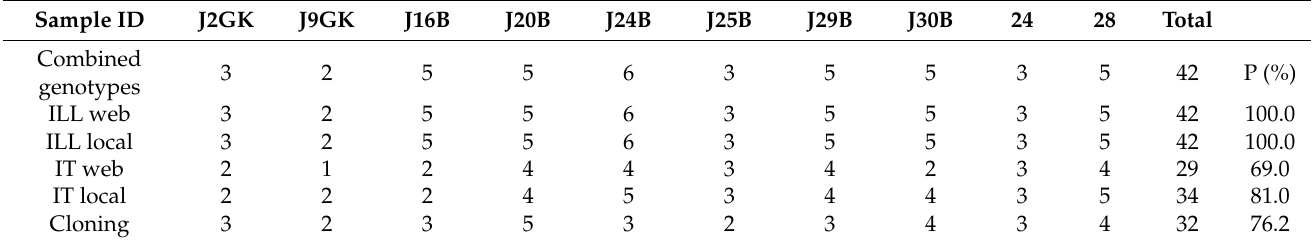
Table 3. MHC-DRB combined genotypes (number of combined alleles), number of alleles detected in individuals, and proportion of the combined genotype detected by different methods (P). ILL web—Illumina web, ILL local—Illumina local, IT web—Ion Torrent web, IT local—Ion Torrent local analysis, cloning—cloning/Sanger sequencing method.